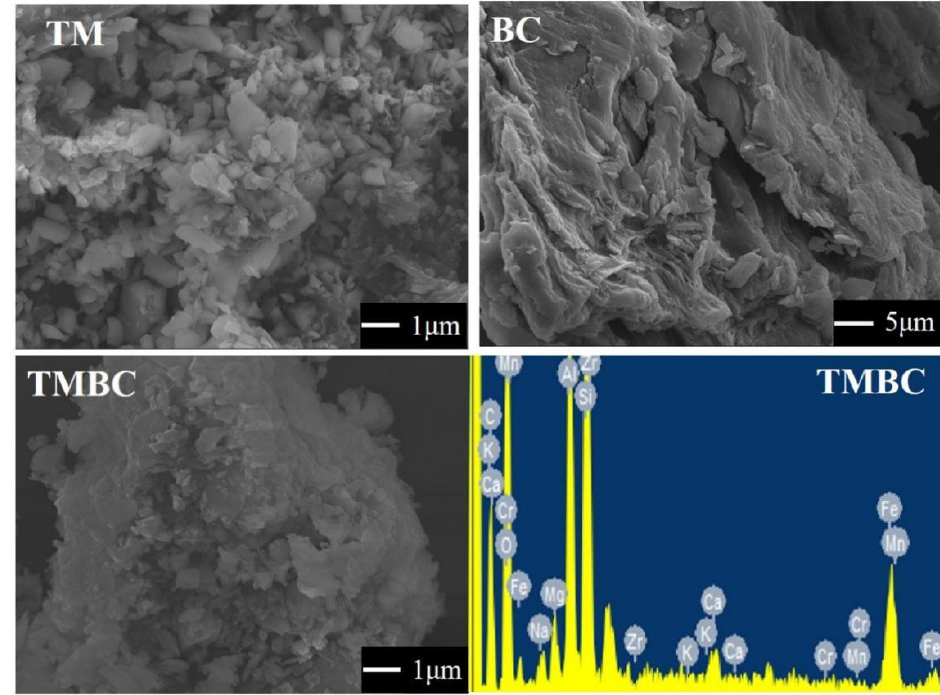
Figure 2. SEM image of tourmaline (TM), biochar (BC), and composite (TMBC).